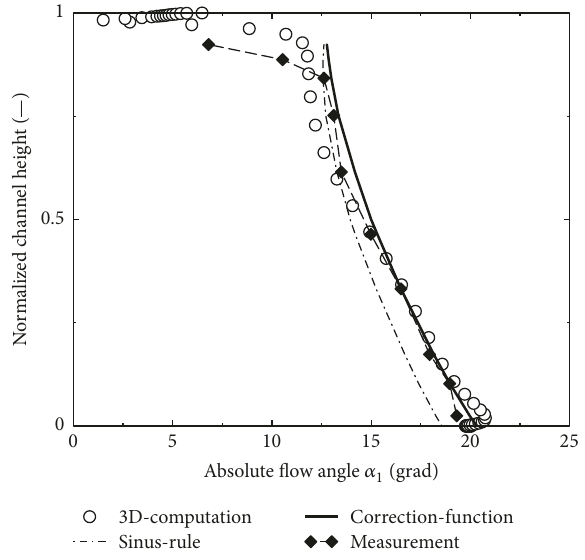
Figure 17: Validation of the deflection model of (25) over the blade height for the curvature blade 𝐵𝑜𝑤 2𝐵 .